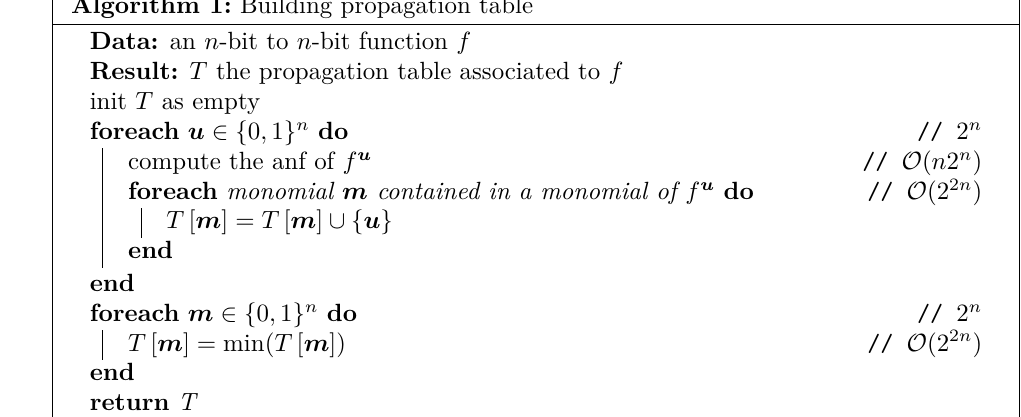
Algorithm 1: Building propagation table Data: an n -bit to n -bit function